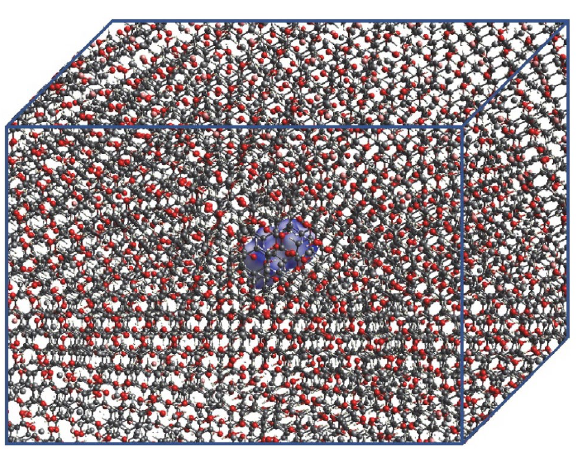
Figure 3: Evolution of values of the dipole moment of the CAD with the respective iteration numbers. A 11 × 11 × 11 unit cell assembly was considered (step 0 indicates the isolated molecule and the other steps indicate the embedded